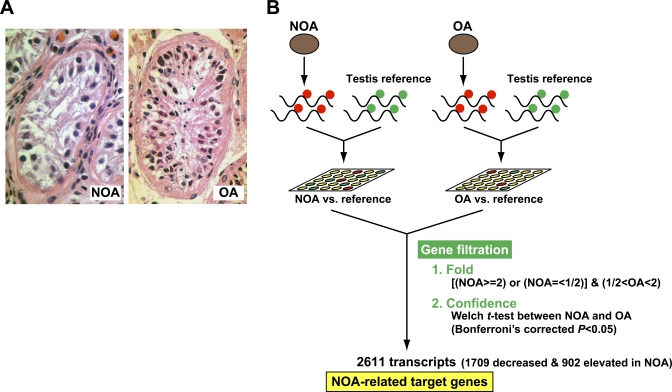
Experimental Design to Extract NOA-related Target Genes(A) Representative testicular biopsies from NOA (left panel) and OA (right panel) patients. The seminiferous tubules in NOA testis show Sertoli cells only; testicular histology of the OA patient indicates the presence of germ cells at all stages of spermatogenesis.(B) Strategy for discovering the NOA-specific expression profile, i.e., the NOA-related target genes. Compared with the expression level of reference RNA, the NOA group, with expression undergoing 2-fold or more mean change, was extracted; the OA group comprised transcripts with less than 2-fold mean expression change. Of the overlapping transcripts, only those with statistically significant difference between NOA and OA (p < 0.05 with Bonferroni's correction) were identified as differentially expressed.